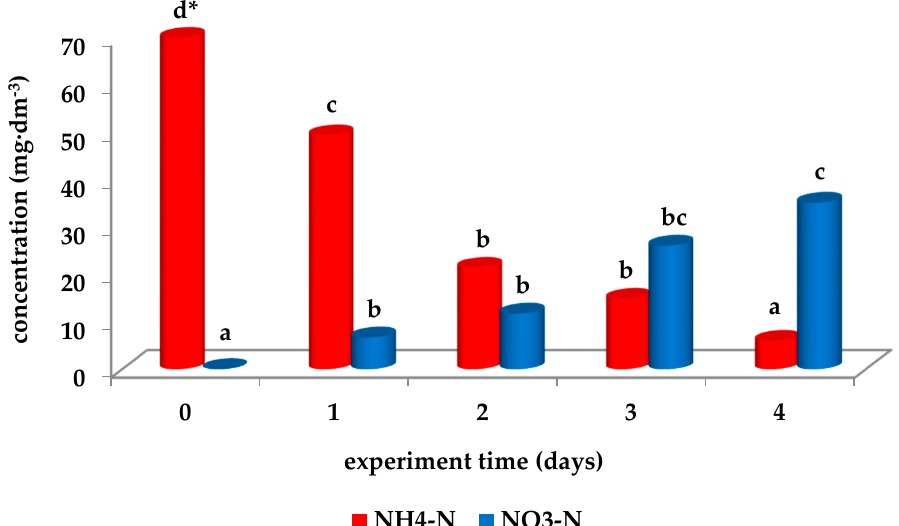
Figure 3. An attempt to colonize activated sludge by nitrifying bacteria; * averages marked with the same letters are not significantly different by Tukey test ( α = 0.05) (one-way ANOVA, separately for concentration of NH 4 ‐ N and NO 3 ‐ N).